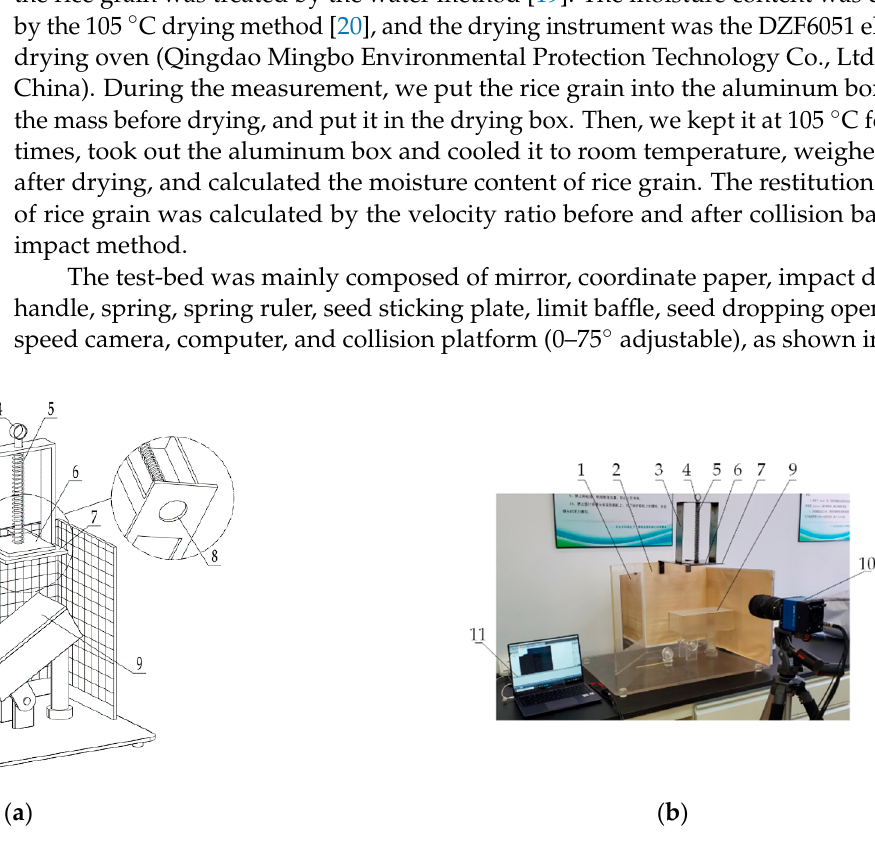
Figure 2. Contact materials: ( a ) rubber plate; ( b ) Q235 steel plate; ( c ) plexiglass plate; and ( d ) seed plate.